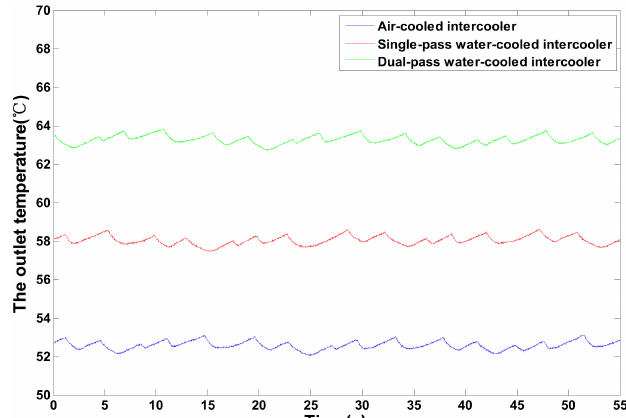
Figure 10. Comparison of charge air temperatures under high-speed running condition. Under high-speed running, the temperature of the charge air outlet in the air-cooled intercooler continues to rise, because the heat exchange capacity of the air-cooled intercooler has reached a bottleneck and cannot meet the cooling demand of the charge air. The outlet temperature of the pressurized air in the water-cooled intercooler is significantly lower than that of the air-cooled intercooler and maintains a thermal equilibrium state, which indicates that the air-cooled intercooler can no longer meet the cooling demand under a high temperature and heavy load environment, while the water-cooled intercooler can meet the cooling demand. When the intake air temperature rises, the water-cooled intercooler can increase the heat exchange capacity by changing the flow rate of the water pump, while the air-cooled intercooler needs to adjust the speed of the cooling fan to improve the heat dissipation capacity. The latter has a longer response time and tends to cause a brief overheating of the